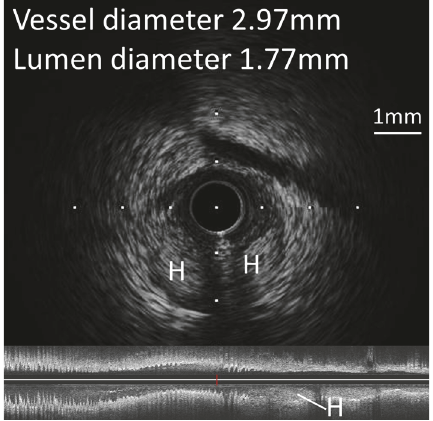
Figure 4: IVUS revealed progression of the intramural hematoma (H) and a totally compressed true lumen at the distal left circumflex artery. An intramural hematoma appears as a homogeneous, hyper- echoic, crescent-shaped area.